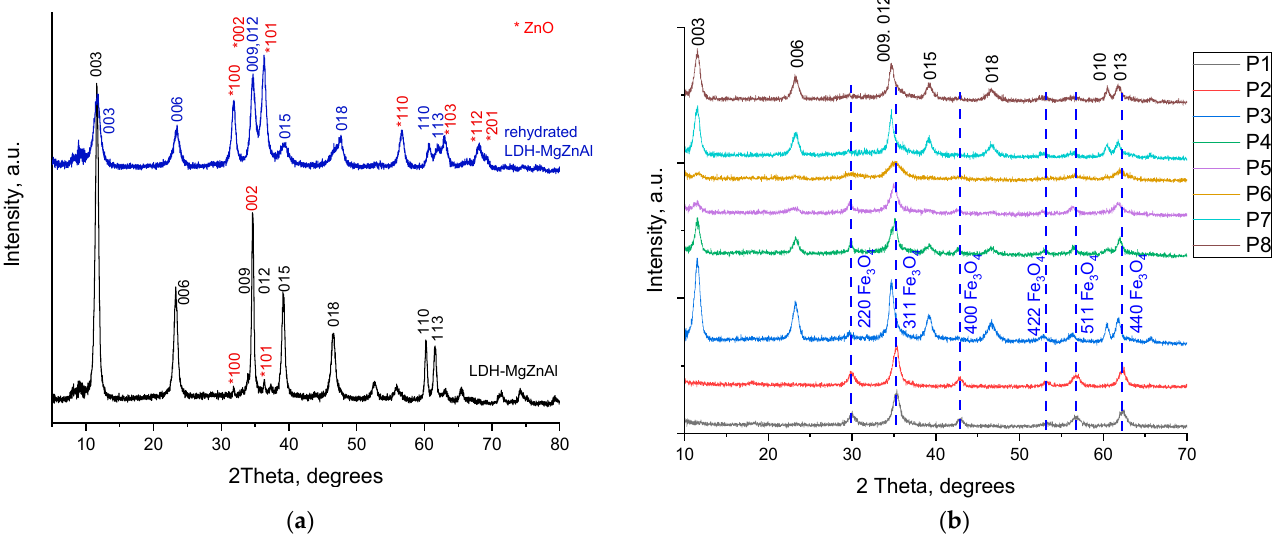
Figure 1. X-ray diffractograms corresponding to ( a ) as-prepared and rehydrated LDH after deposition of CuPc and ( b ) P1–P8 catalysts.